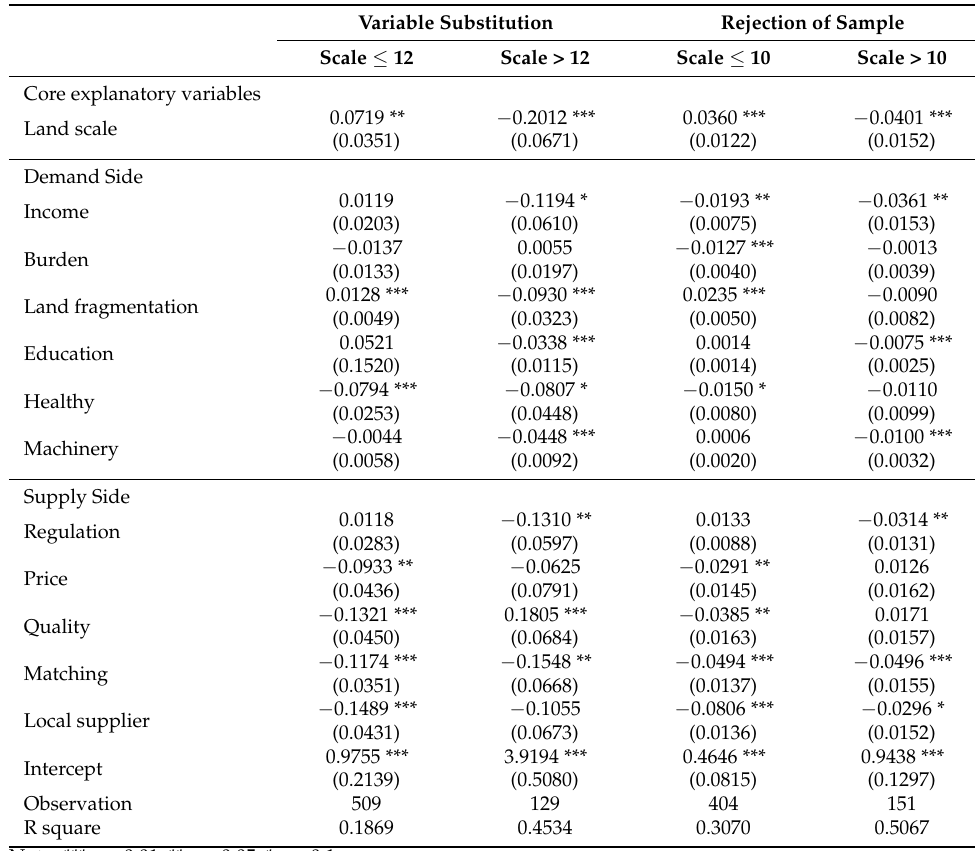
Table 8. Results of robustness